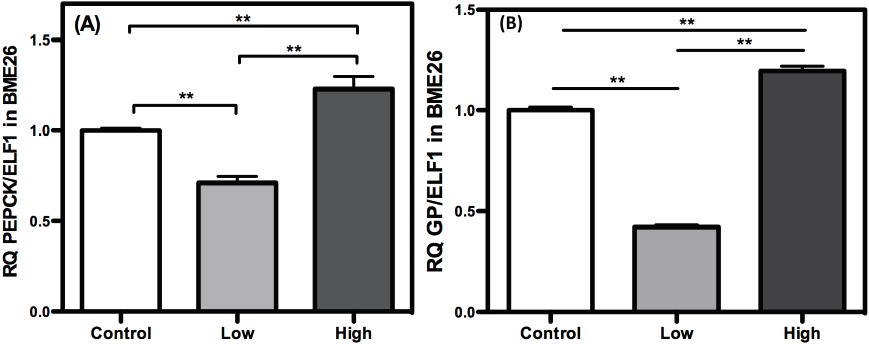
Figure 7. Gluconeogenic response increase in high glucose concentration in BME26 cells. Transcriptional analysis of PEPCK ( A ) and glucose-6-phosphatase ( B ), gluconeogenic key-enzymes, in embryonic Rhipicephalus microplus cells (BME26) in response to glucose treatment. Control: cells maintained with 50 mM of glucose; Low: cell maintained without glucose addition; and High: cells maintained with 100 mM of glucose. The experiment was performed with three independent biological samples in three experimental replicates each ( ** p < 0.001,